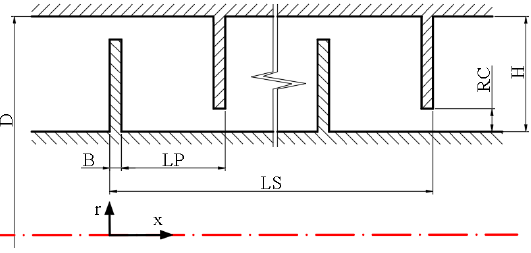
Figure 2. Illustrative geometry of a staggered labyrinth seal.